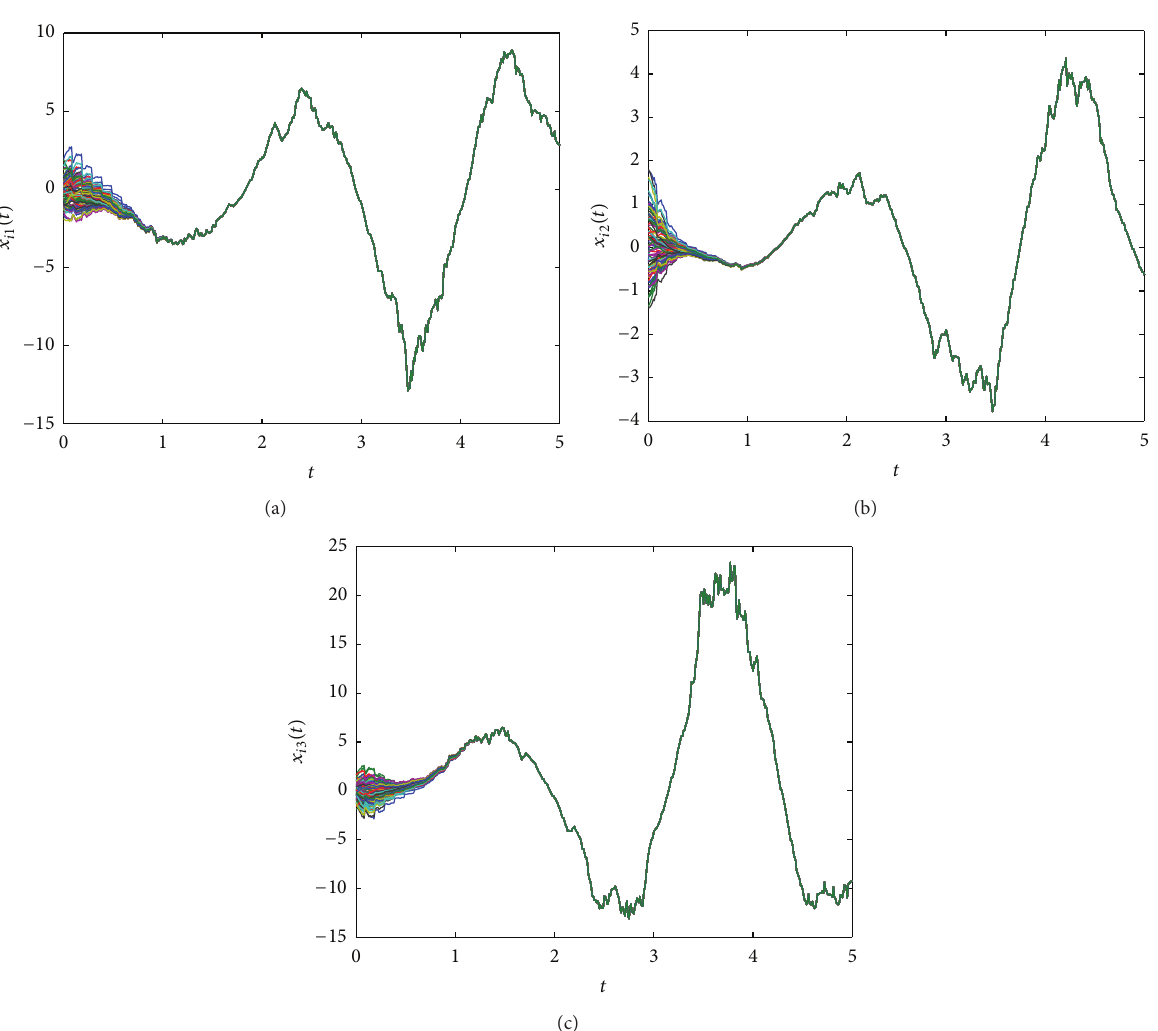
Chua’s circuit with above permeates and Brownian